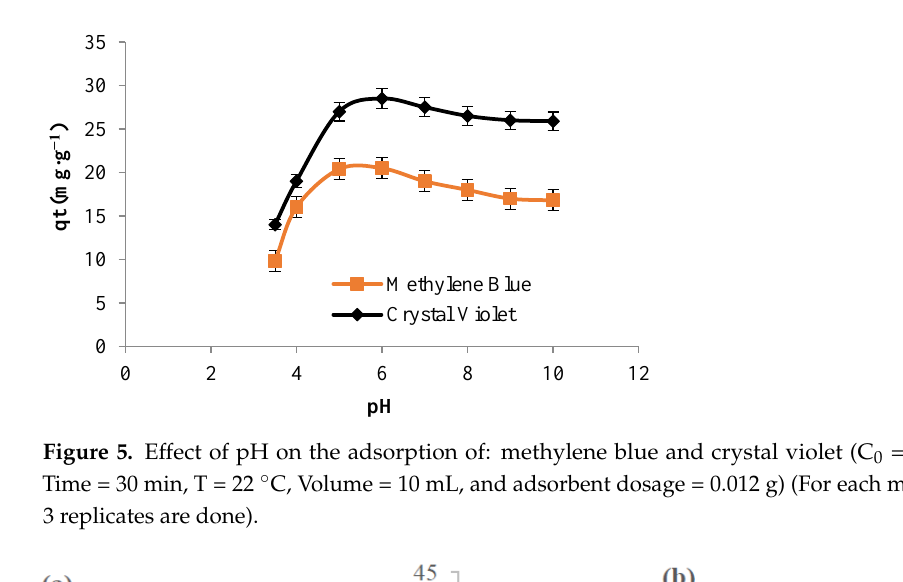
Figure 5. Effect of pH on the adsorption of: methylene blue and crystal violet (C 0 = 30 mg L − 1 , Time = 30 min, T = 22 °C, Volume = 10 mL, and adsorbent dosage = 0.012 g) (For each measurement, 3 replicates are done).